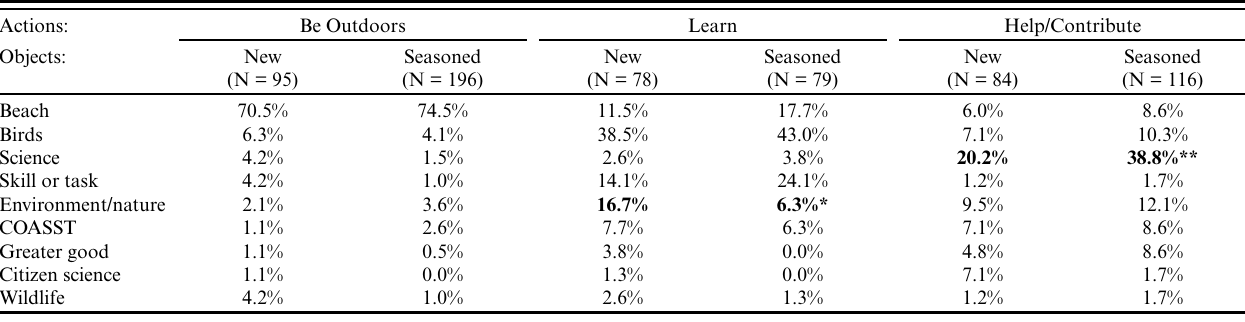
Table 3 . Co-occurrence of object*action codes, limited to the three most prevalent action codes: be outdoors, learn, and help/contribute (see Fig. 2). All other formatting as in Table 2. COASST, Coastal Observation and Seabird Survey Team.